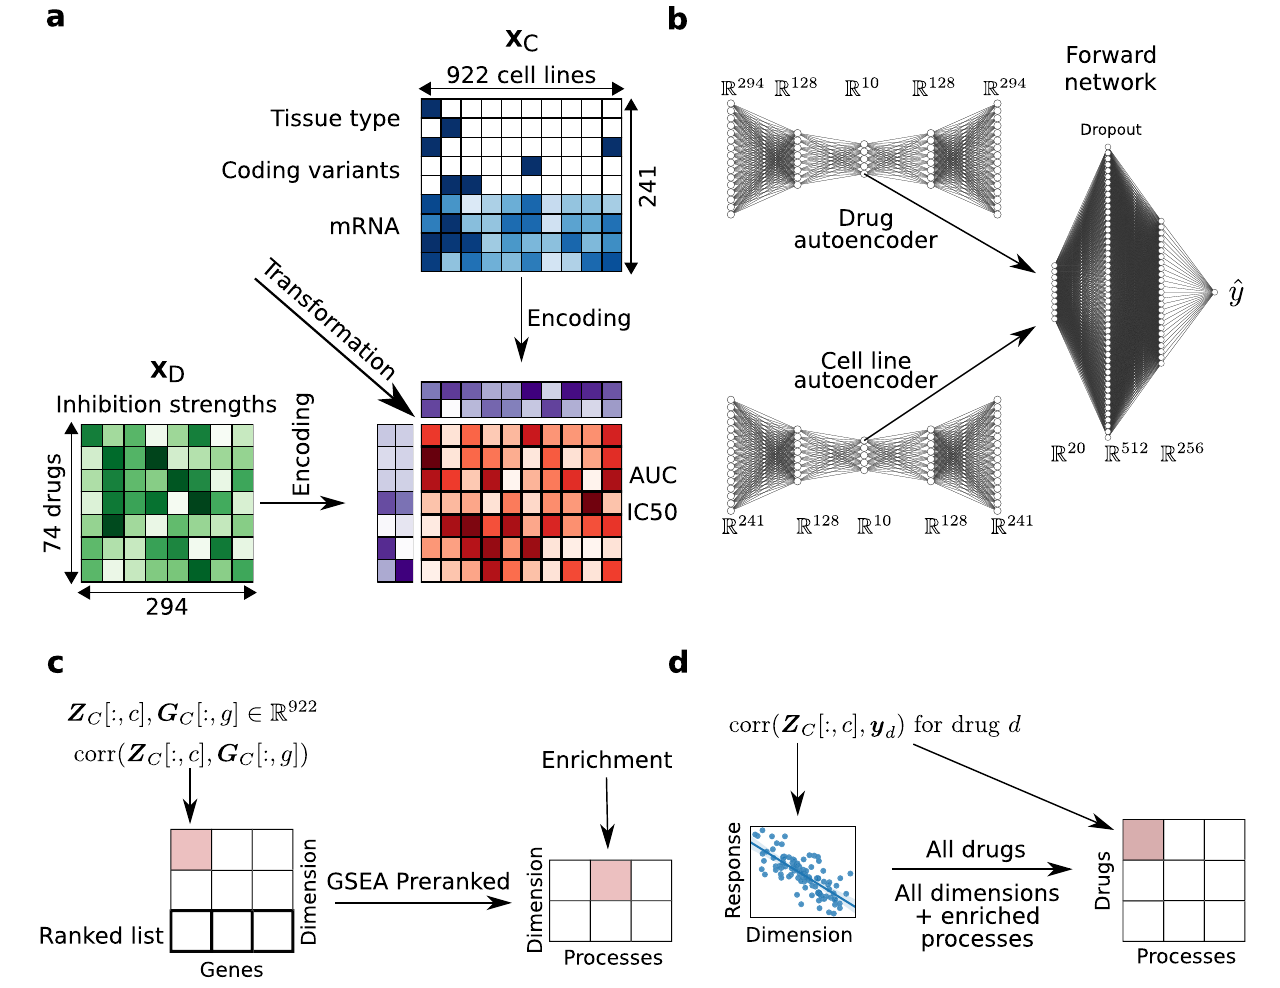
Figure 1. Overview of the data and the modeling process. ( a ) Recommender system framework for drug sensitivity prediction from drug and cell line features. The drugs are described by their inhibition profiles on a panel of 294 kinases. The biological features of the cell lines include continuous mRNA expressions, binary indicators of coding variants, and dummy-encoded tissue type. Two drug response metrics are considered: AUC and IC50. The recommender system first independently encodes drugs and cell lines input data into lower- dimensional representations. The two hidden representations are then transformed in order to compute the drug response estimation. ( b ) Architecture of the DEERS model. First, the drugs and cell lines inputs are passed into corresponding autoencoders which output the 10-dimensional representations and reconstructed data. Next, the hidden representations are concatenated and used as an input to the two-layered, feed-forward network which outputs the drug response estimate. ( c ) Method for relating biological meaning to hidden dimensions of cell lines. First, the hidden dimensions of the cell line autoencoder are correlated with gene expression data. Here, Z Z G , c ] denotes a column of Z C denotes the matrix with cell line hidden representations stacked in rows, C [: C , C denotes the gene expression data for cell lines and G C [: , g ] denotes a column of G C . The resulting ranked lists, one per each dimension, are then passed as an input to GSEA Preranked analysis, obtaining biological processes enriched in every hidden dimension (see “Methods” section). ( d ) Method for relating the drug action directly to biological processes. For a given drug d , the cell line response is correlated with a given cell line hidden dimension c . The obtained correlation coefficient is then mapped to the biological processes enriched in hidden dimension c . This procedure is performed for every drug and every hidden dimension, obtaining the matrix relating drugs to the biological processes (see “Methods” section). For graphics, we used Matplotlib 67 , seaborn 68 , NN-SVG 69 , and Inkscape version 1.1 (https:// inksc ape.